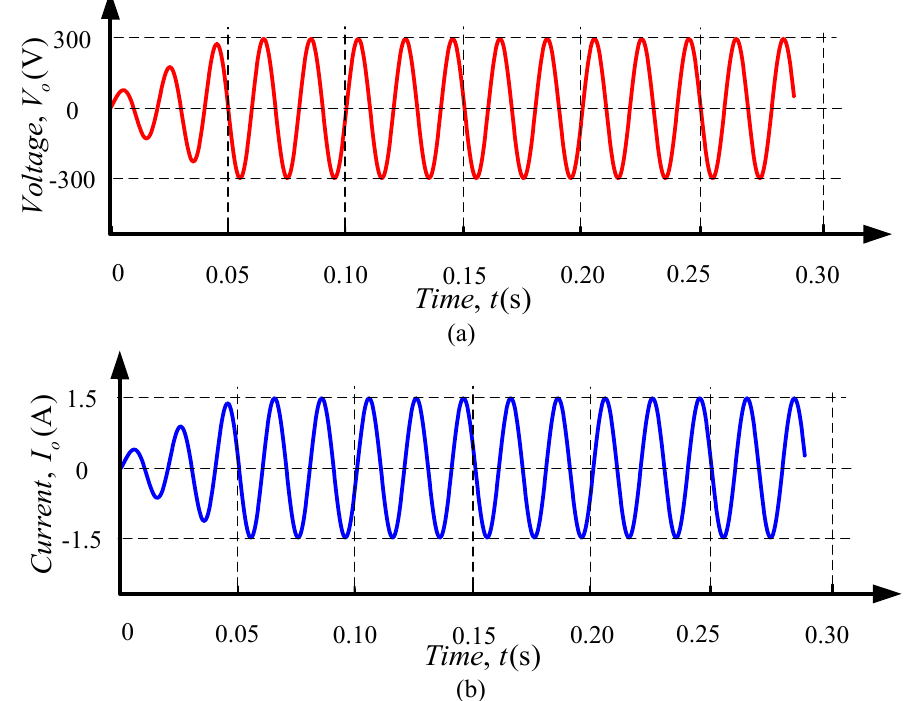
Figure 15. Output: ( a ) Inverter output voltage; ( b ) output current.